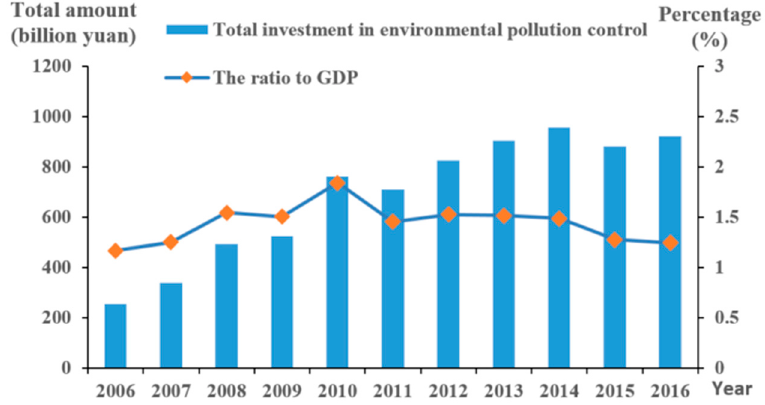
Figure 9. Total investment in environmental pollution control.